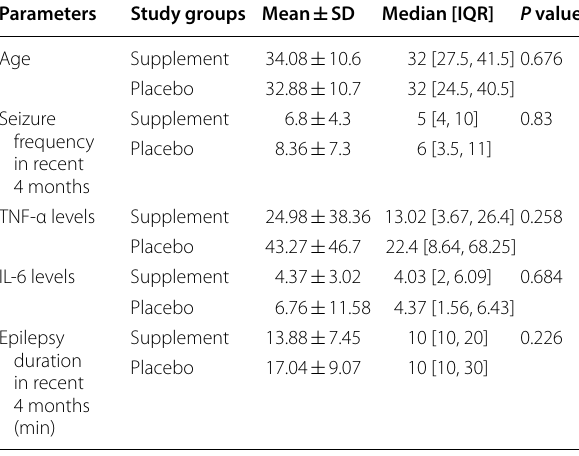
Table 2 Baseline measurements in the study